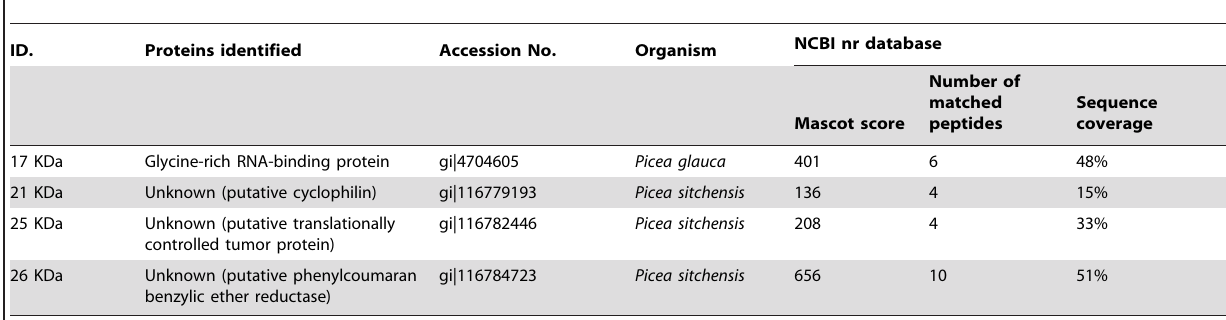
Table 1. Identification of protein candidates showing significant changes in expression level in response to anti-CaM treatment.